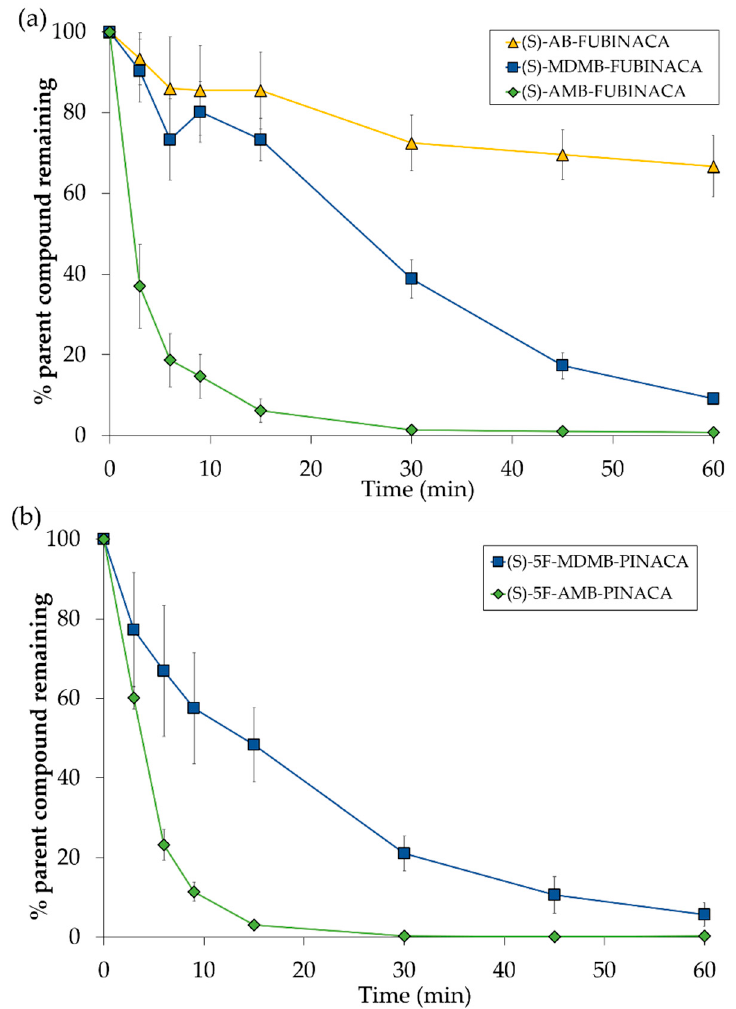
Figure 4. ( a ) Differences in clearance of ( S )-AB-FUBINACA ( 8 ), ( S )-MDMB-FUBINACA ( 6 ) and ( S )-AMB-FUBINACA ( 1 ) incubated in pooled human cryopreserved hepatocytes (pHHeps) ( n ≥ 3 ± SD). ( b ) Differences in clearance of ( S )-5F-MDMB-PINACA ( 2 ) and ( S )-5F-AMB-PINACA ( 10 ) incubated in pooled human cryopreserved hepatocytes (pHHeps) ( n ≥ 3 ± SD).